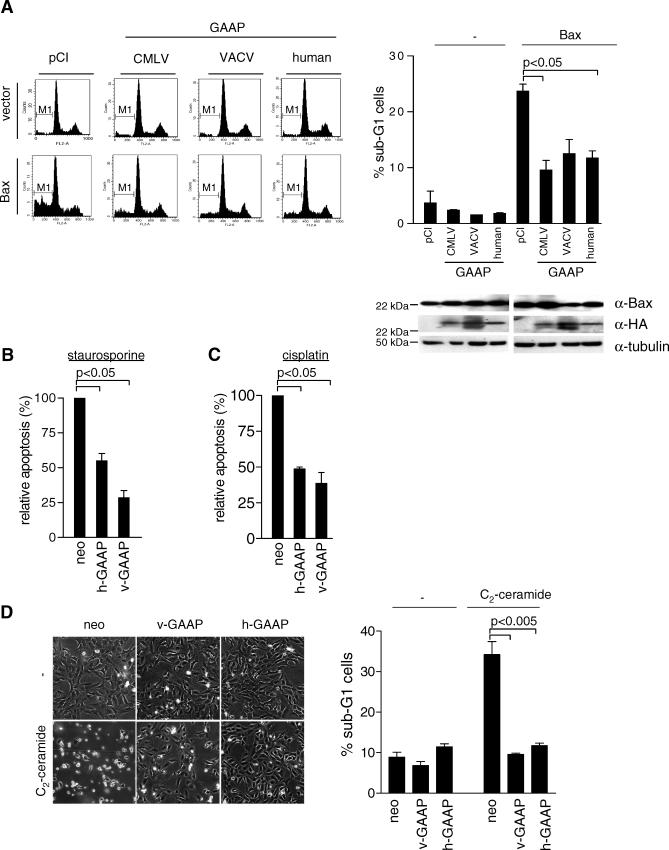
h-GAAP Decreases Cell Susceptibility to Intrinsic Apoptosis Pathways(A) Transient assay of Bax-induced apoptosis. Saos-2 cells were transfected with different plasmids as indicated, and representative flow cytometry profiles of CD20-positive cells are shown. The bar graph represents the percentage of sub-G1 cells (labeled M1 in the left panel). Data are mean percentages from at least two independent experiments. Protein expression was detected by immunoblotting using α-Bax or α-HA antibodies, respectively.(B–D) U2OS-neo, U2OS-v-GAAP, or U2OS-h-GAAP cells were mock-treated or treated with 3 μM staurosporine for 6 h (B), 10 μg/ml cisplatin for 24 h (C), or 10 μM C2-ceramide for 36 h (D), and apoptosis was assessed as above. The graphs show the relative percentage of apoptosis induced by staurosporine (B) or cisplatin (C). Data are mean percentages (± 1 standard deviation [SD]) from at least two independent experiments done in triplicate.(D) After 24 h treatment with C2-ceramide, the cell morphology was recorded as for Figure 3B. The graphs show the percentage of sub-G1 cells induced by C2-ceramide. Data are mean percentages (± 1 SD) from at least two independent experiments done in triplicate. Statistically significant differences are shown.